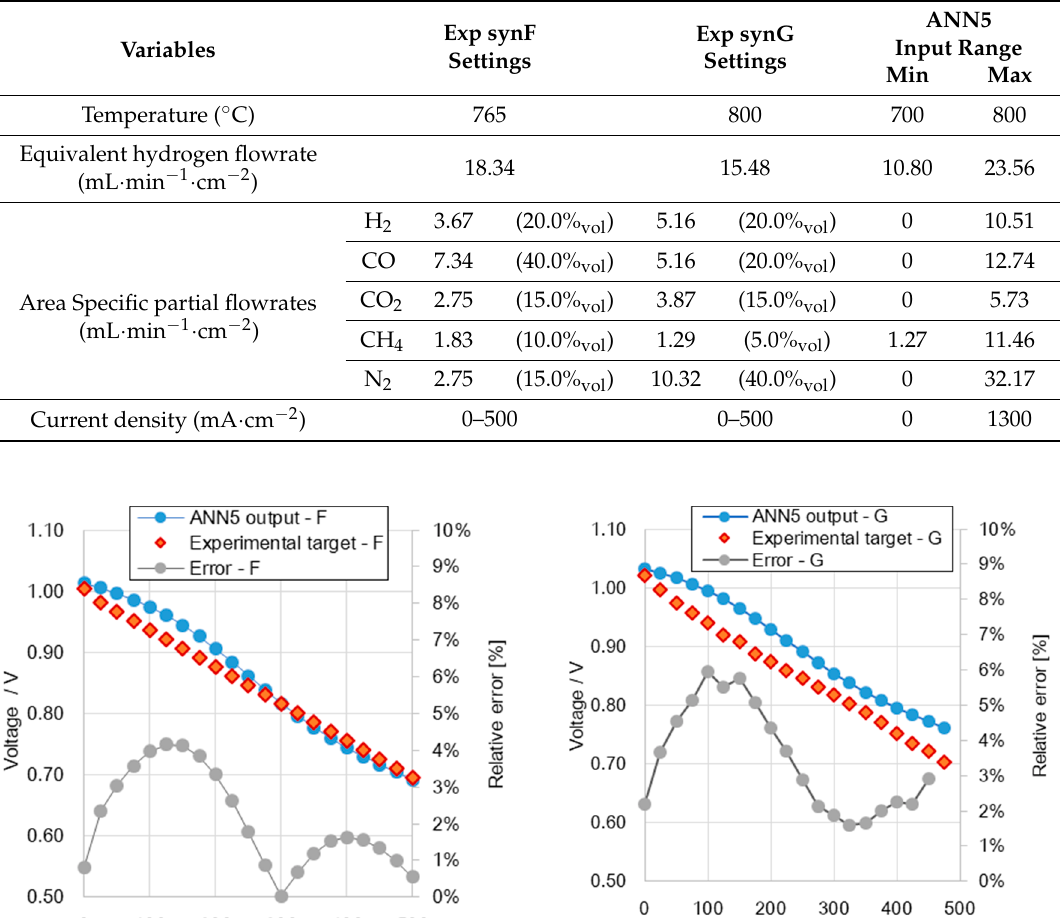
Table 5. Validation experiments input data.